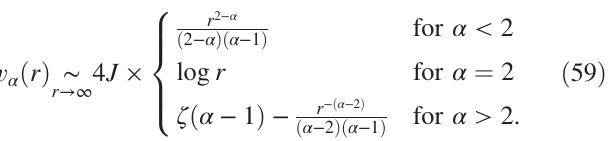
ϵ ¼ 0 . 1139 . Quantized trajectories undergo a transition between spatially localized (red) and delocalized (blue), representing a discrete sequence of nontopological con- fined bound states below a continuum of topological unbound domain walls. For this choice of parameters, N ϵ Þ ¼ 4 ; however, this number grows as ϵ → 0 . A clear α ð signature of these bound states is further given by the presence of pronounced peaks in the power spectrum of the absolute value of the order-parameter time series. In Fig. 16, we show the Fourier transform of finite-size data for α ¼ 2 . 25 . In the long-range limit ( R ¼ ∞ ) the two main peaks correspond to the lower-energy